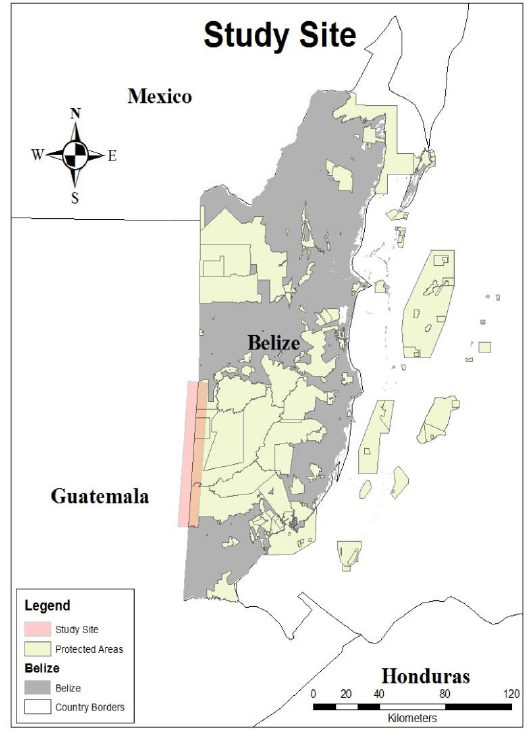
Figure 1. Belize-Guatemala MMM border Petén is Guatemala’s northern most district and one of the fastest growing. It is Guatemala’s last frontier and national policy has encouraged immigration and agricultural expansion.